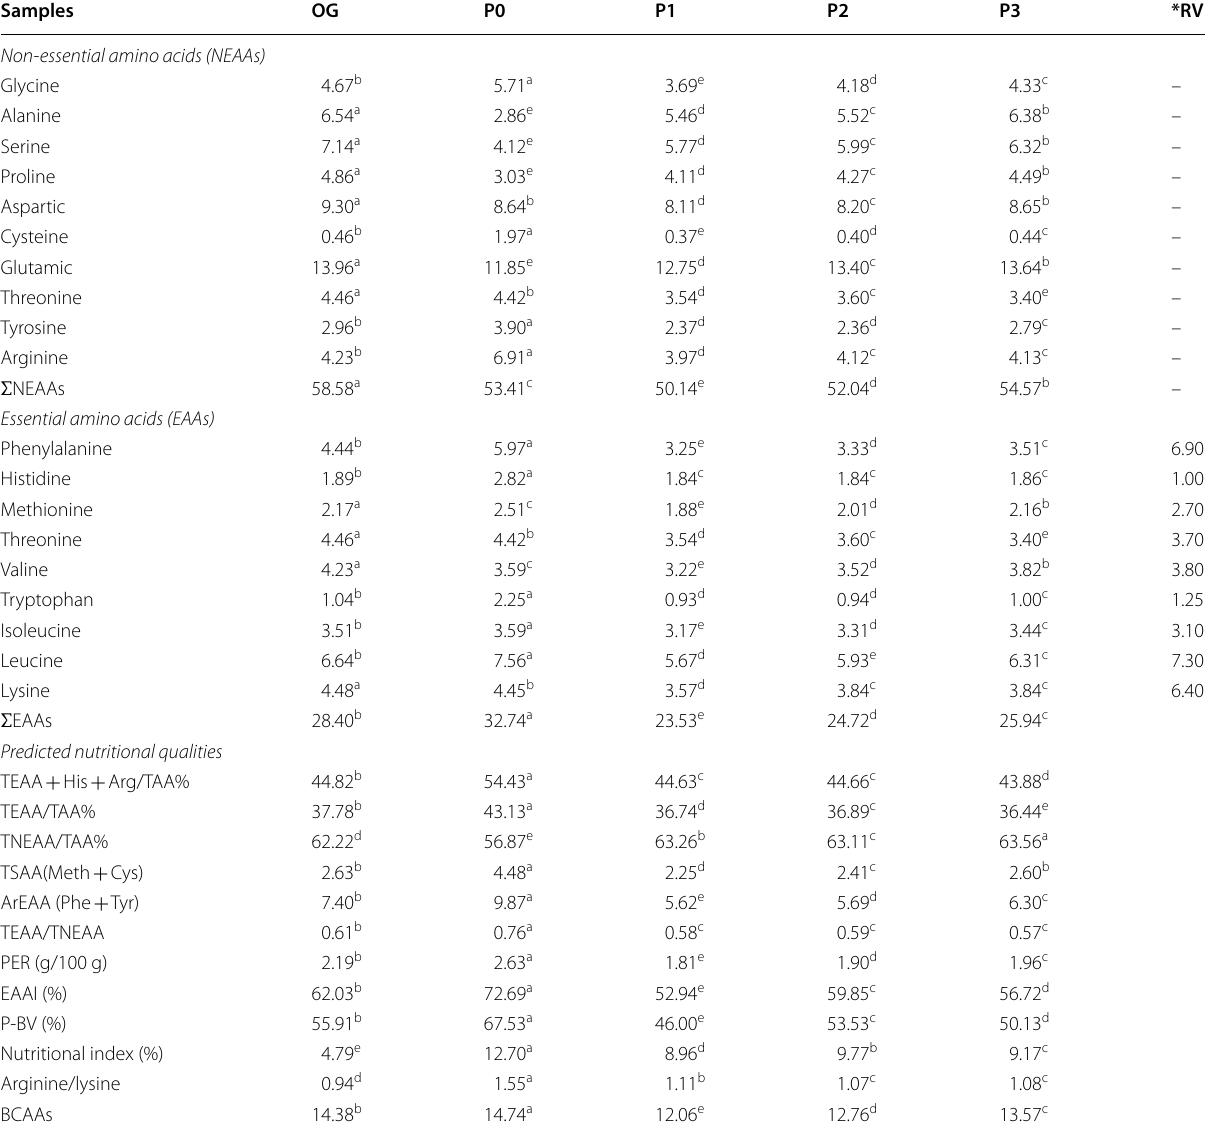
Mean values with the different superscript within the same row are significantly different from each other ( p